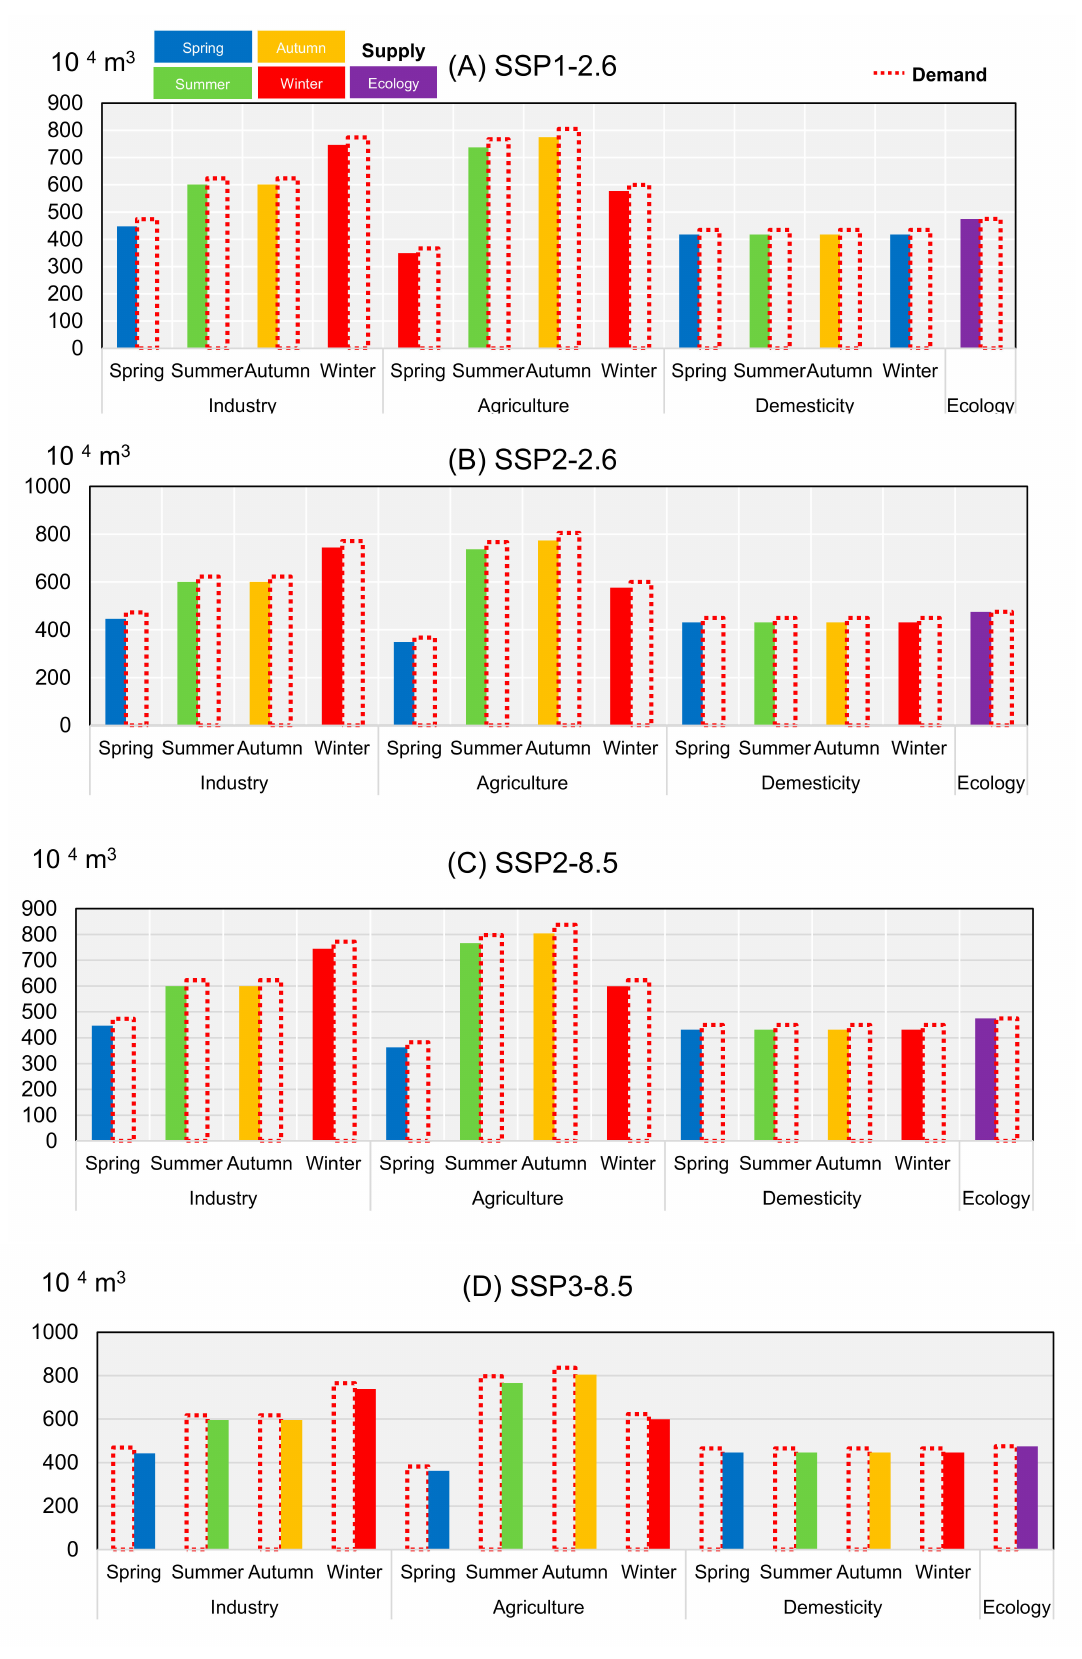
Figure 3. Seasonal water allocation strategies in four sectors in Shaanxi Province. ( A ) SSP1-2.6; ( B ) SSP2-2.6; ( C ) SSP2-8.5; ( D )